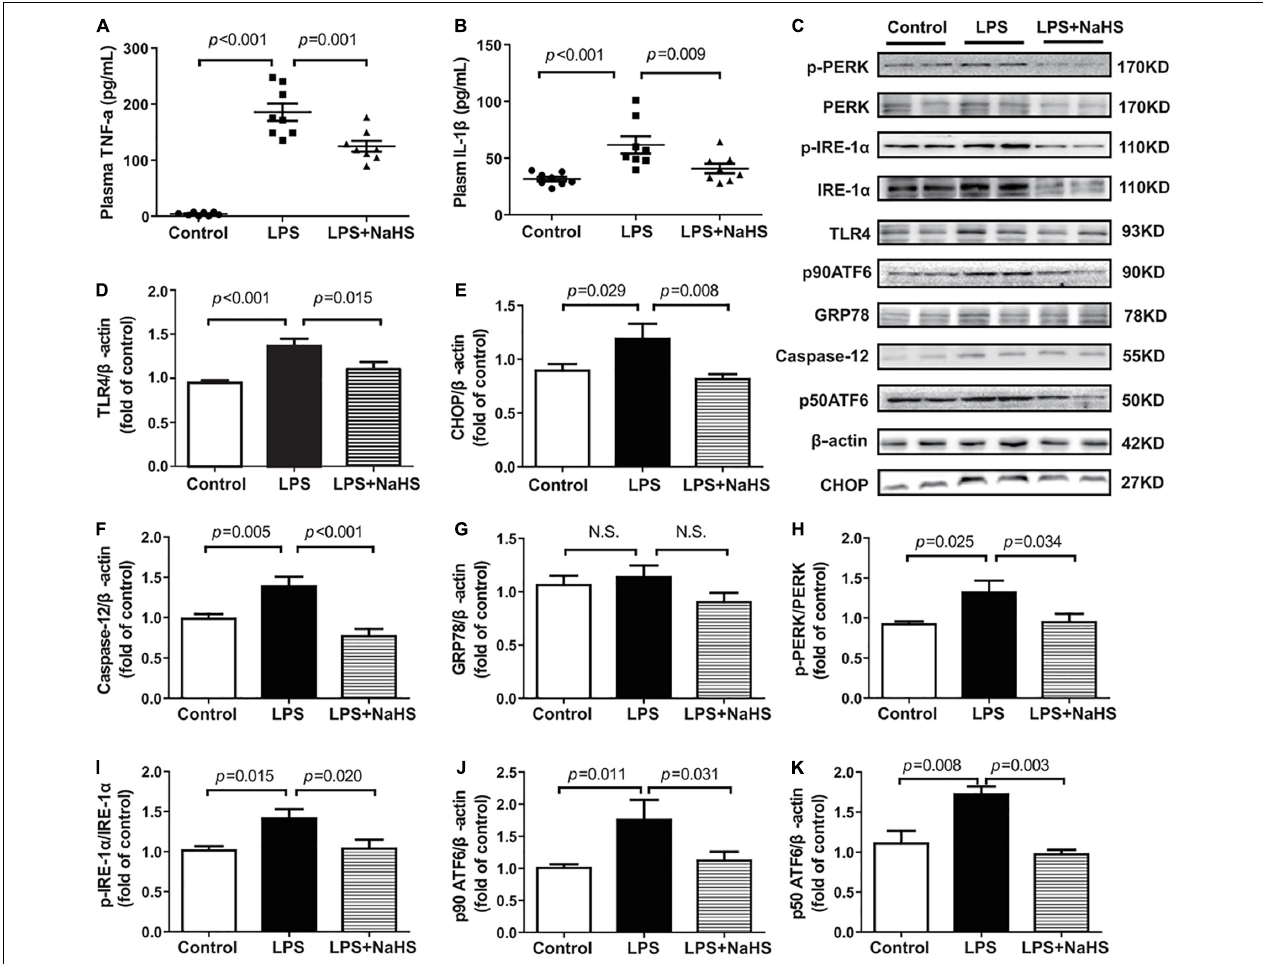
FIGURE 5 | H 2 S inhibited inflammation and ERS in LPS-induced myocardial dysfunction: (A) TNF- α levels in the plasma. (B) IL-1 β levels in the plasma. (C–K) Representative Western blots and quantitative analysis for TLR4, CHOP, Caspase-12, GRP78, p-PERK/PERK, p-IRE1/IRE1, p90 ATF6, and p50 ATF6 protein expression in heart tissues. β -actin was used as the internal control. n = 8 in every group. Results are means ± SEM. p < 0.05 was considered